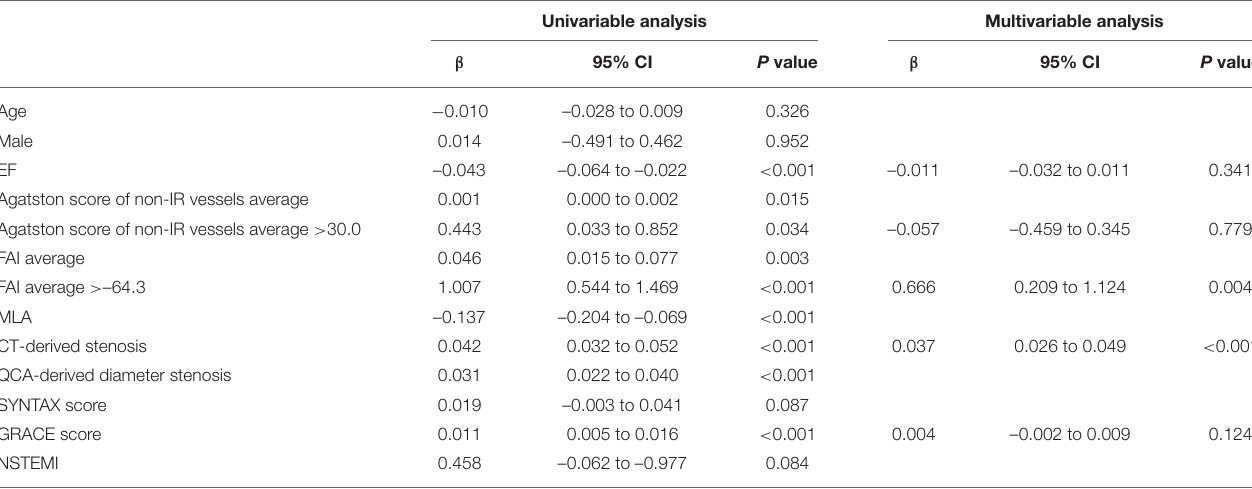
TABLE 4 | Univariable and multivariable linear regression analysis of predicting non-IR LGE